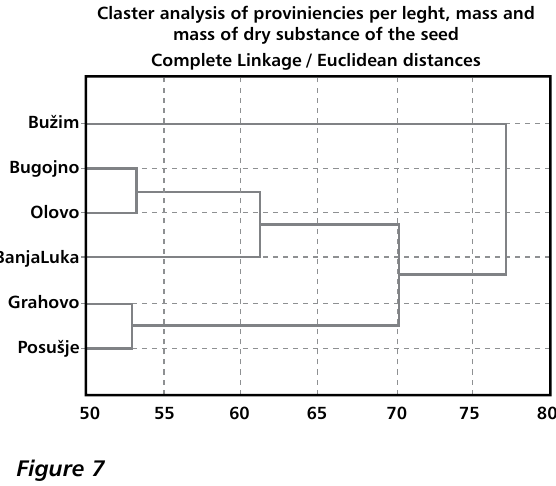
Dendrogram of cluster analyses made based on the measured data on length, width, mass and mass of dry substance of the seed of the analyzed